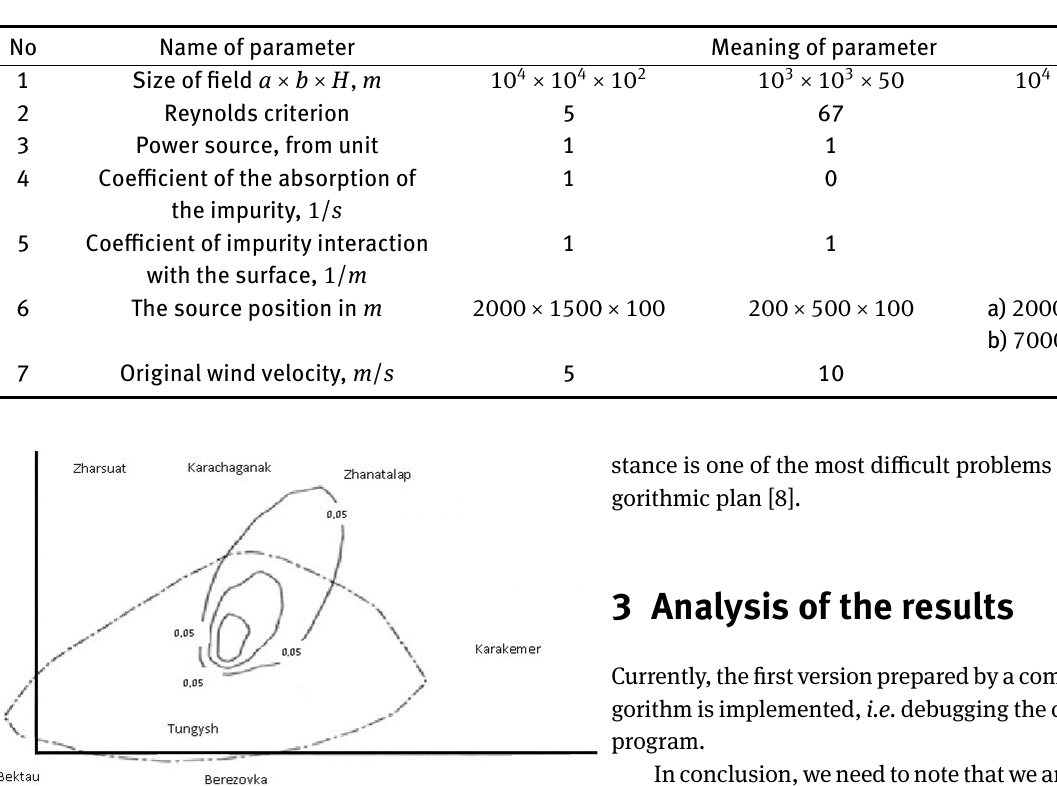
Table 1: Table of regime parameters.